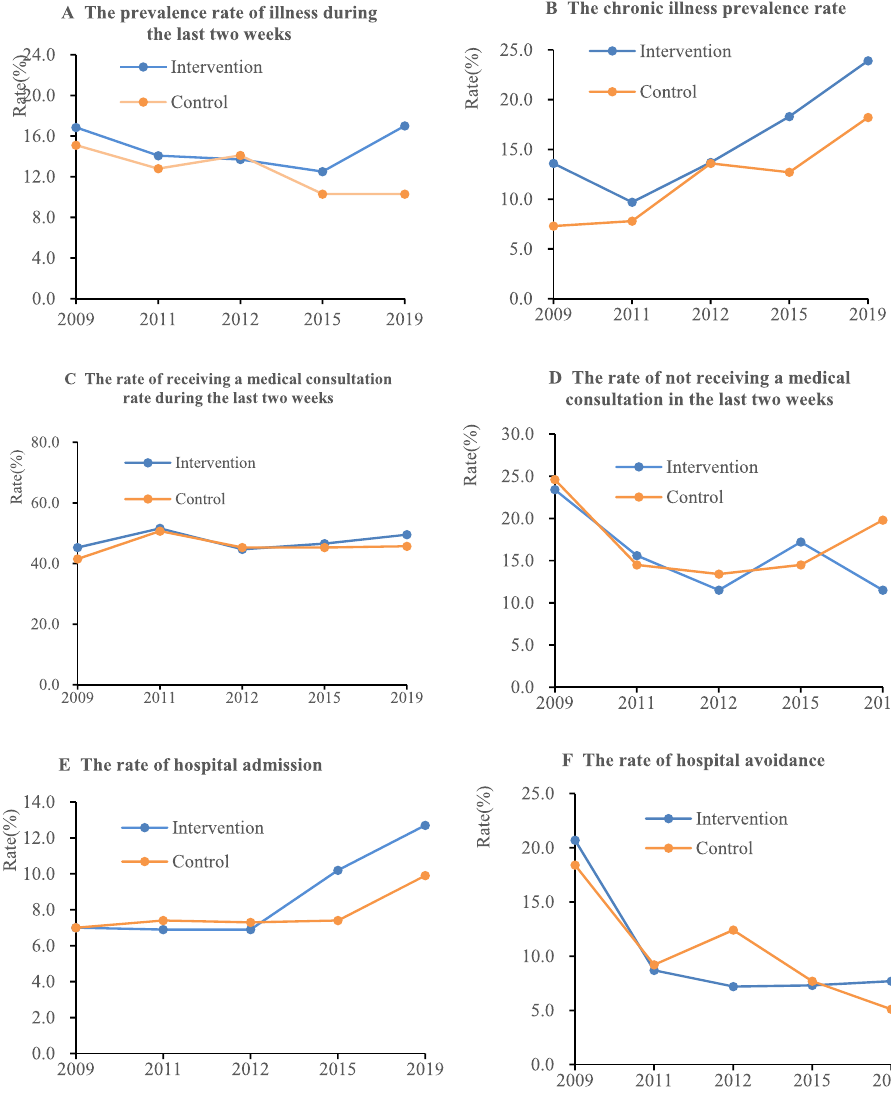
Figure 1. Changes in the need for and utilization of health services among rural residents in Ningxia, China, from 2009 to 2019.